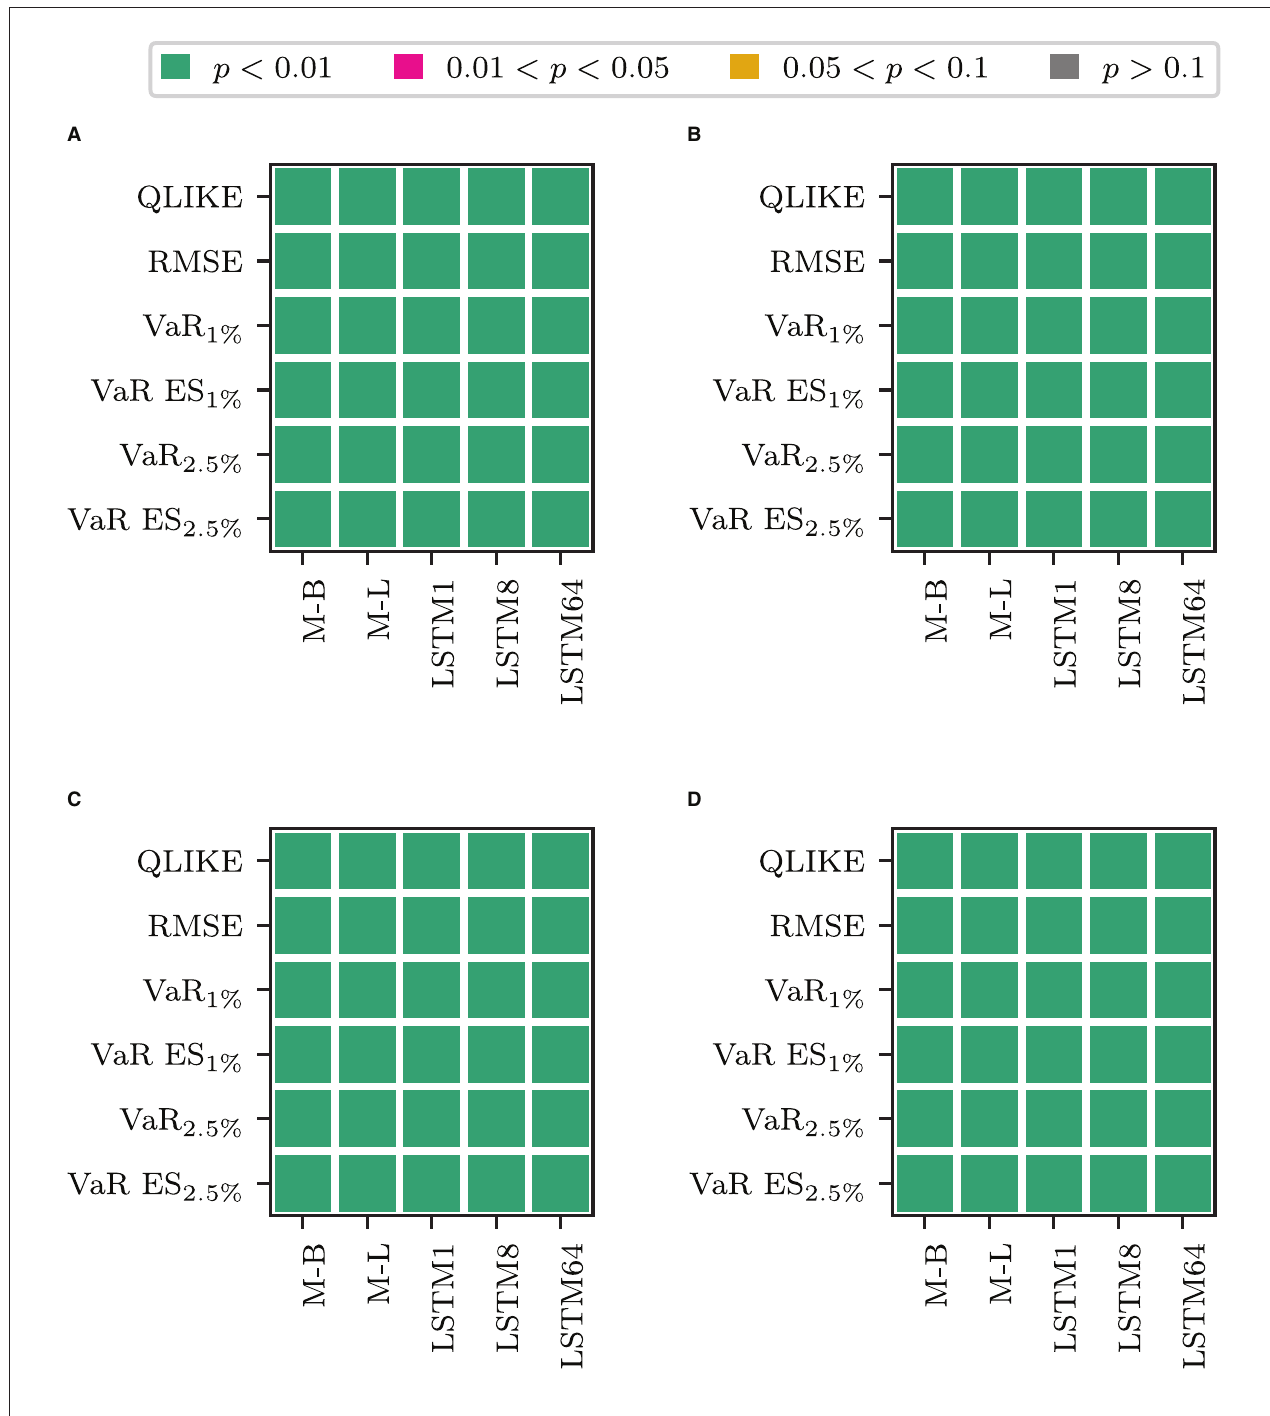
FIGURE 2 | Results for a Binomial test of equal forecasting performance between the models that use only the transformed measure and their counterpart that use it in combination. (A) HAR-F vs. O-F. (B) HAR vs. O. (C) LSTM-F vs. O-F. (D) LSTM vs. O.